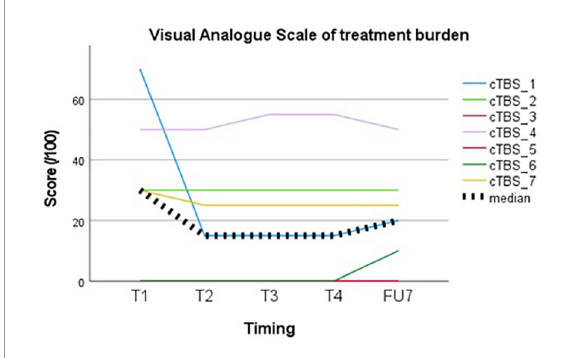
FIGURE2 Visual representation of treatment burden perceived by the